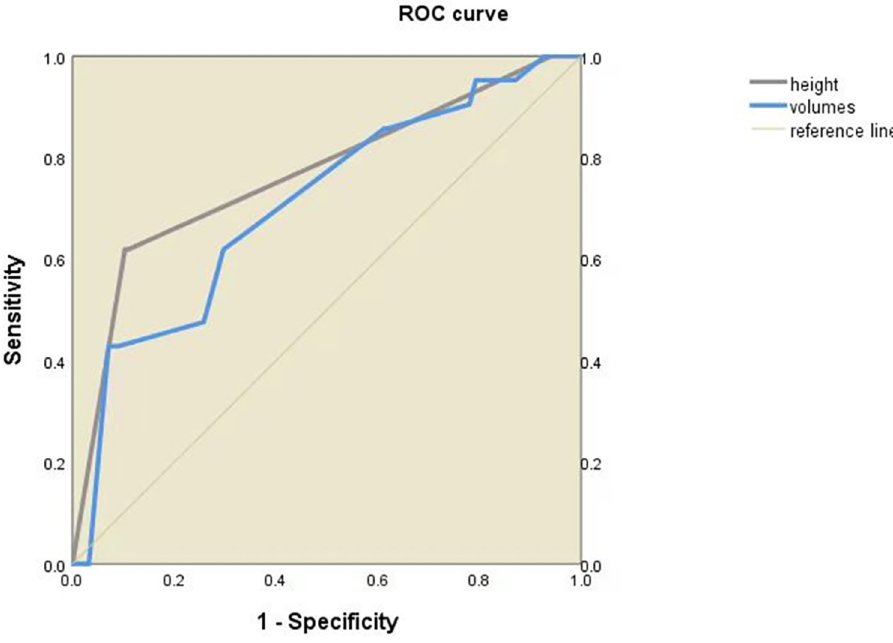
Fig 1. Preterm delivery is predicted using the ROC curve with cone height and volume.